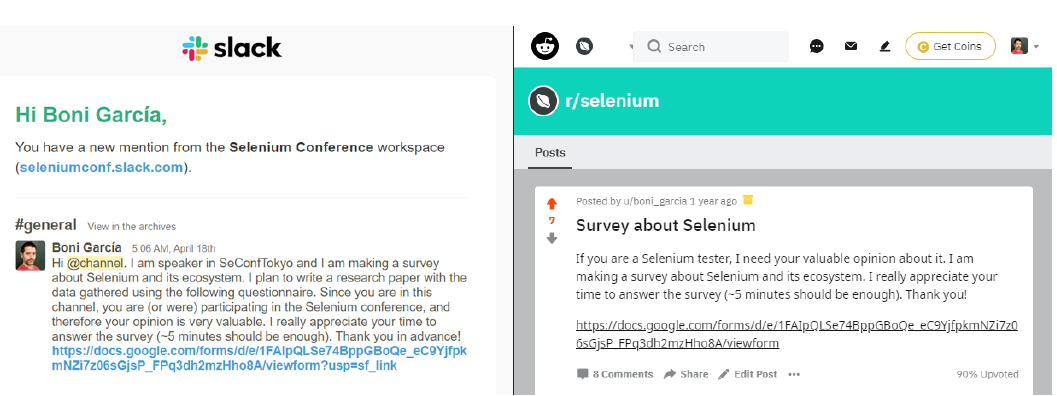
Figure 3. Screenshots of the messages posted on the SeleniumConf Slack workspace ( left ) and Selenium Reddit community ( right ) to recruit participants for the